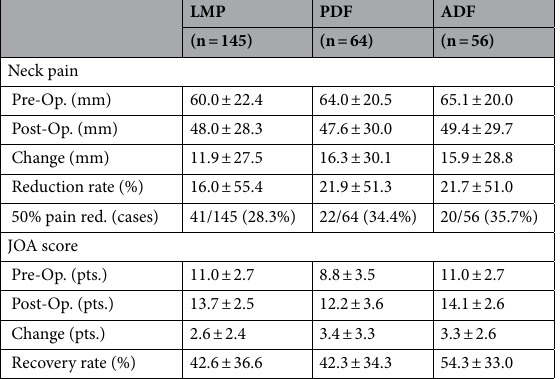
Table 3. Comparison of postoperative neck pain reduction and JOA score between surgical procedures. There was no significant difference in neck pain attenuation and JOA score recovery between laminoplasty, PDF and ADF.